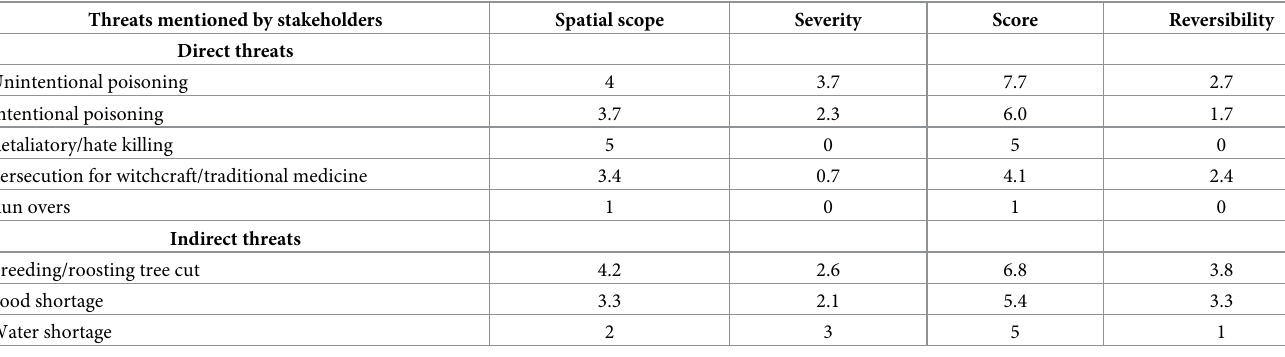
Table 5. Mean values of the threat ranking exercise (n =